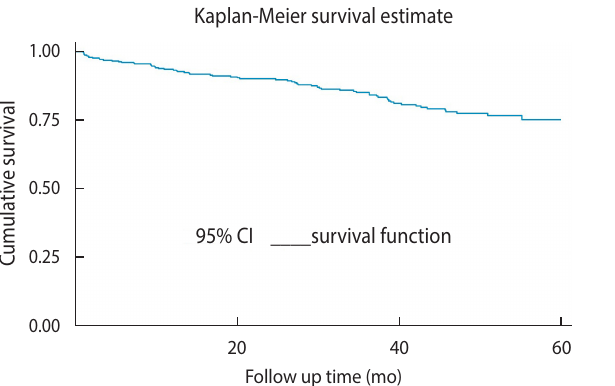
Figure 2. Kaplan-Meier survival curve for tuberculosis-free survival based on cotrimoxazole preventive therapy among children receiv- ing chronic human immunodeficiency virus care at Adama Referral Hospital and Medical College (n=362).